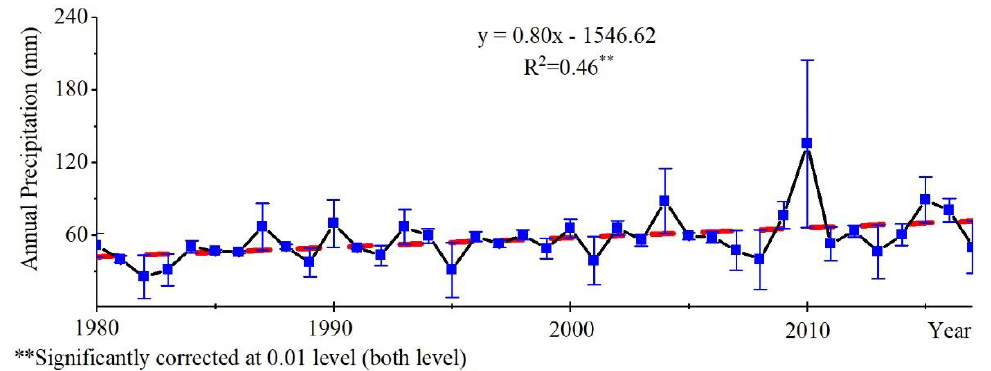
Figure 3. Precipitation changes during snow season in Northern Xinjiang from 1980 to 2017.